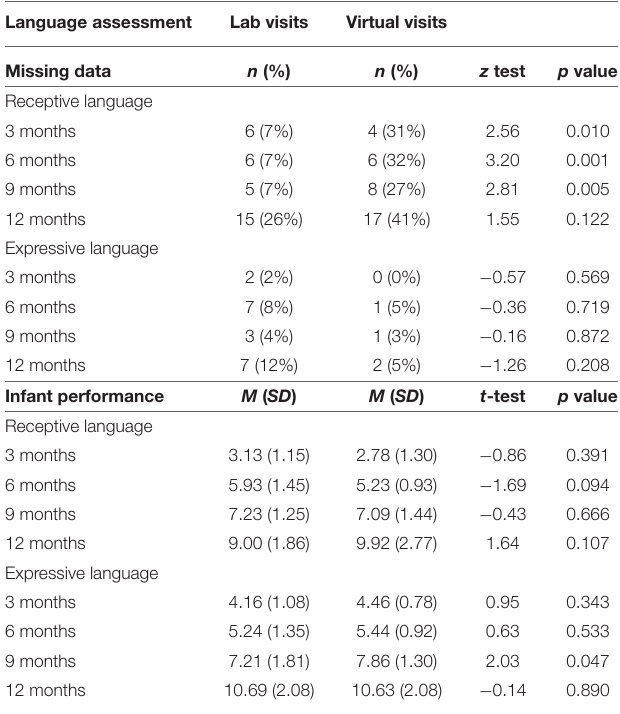
TABLE 6 | Infant receptive and expressive communication: missing data and infant performance as a function of visit type and time point. Language